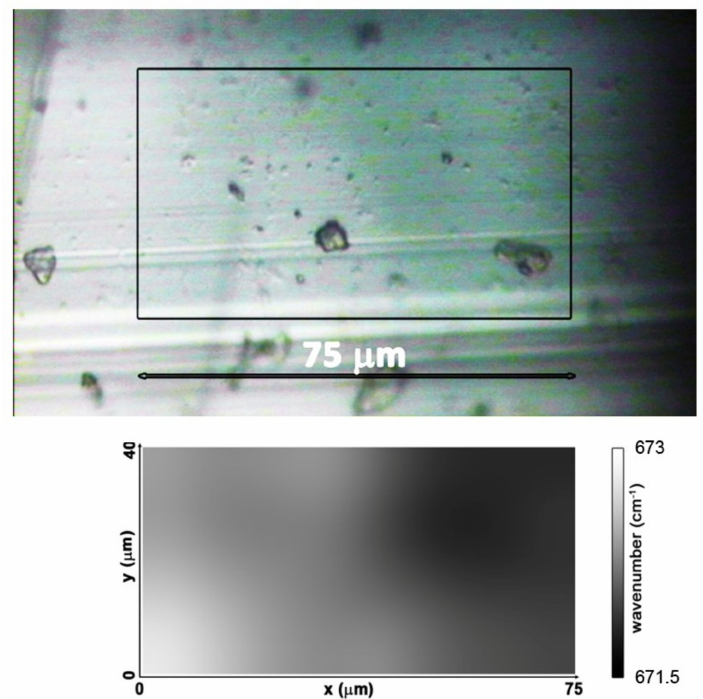
Figure 3. Microscope image ( top ) and Raman map ( bottom ) representing the shift of the main A g band obtained on a zoned actinolite crystal.